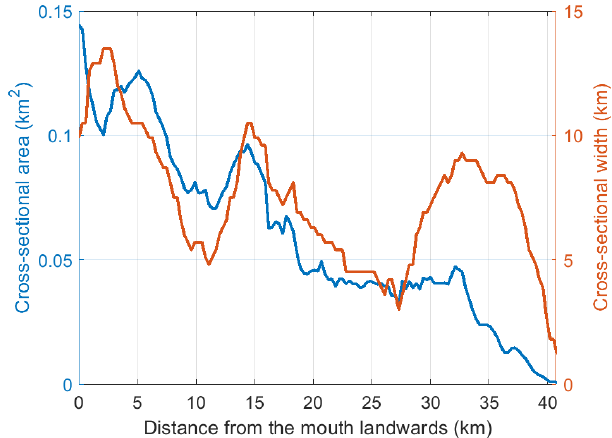
Figure 6. The cross-sectional area and width of the Oosterschelde from the mouth to its eastern end. The northern branch (Fig. 1) is excluded from the calculation because of a different orientation of